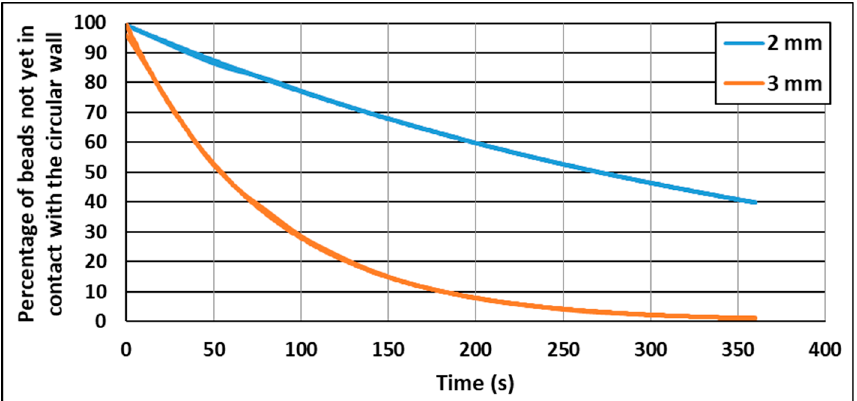
Figure 10. The simulated percentage of beads that had not yet been in contact with the peripheral wall versus mixing time for the bi-size bed (drum filled at 1/3, 4 baffles of 4 cm, rotation 6